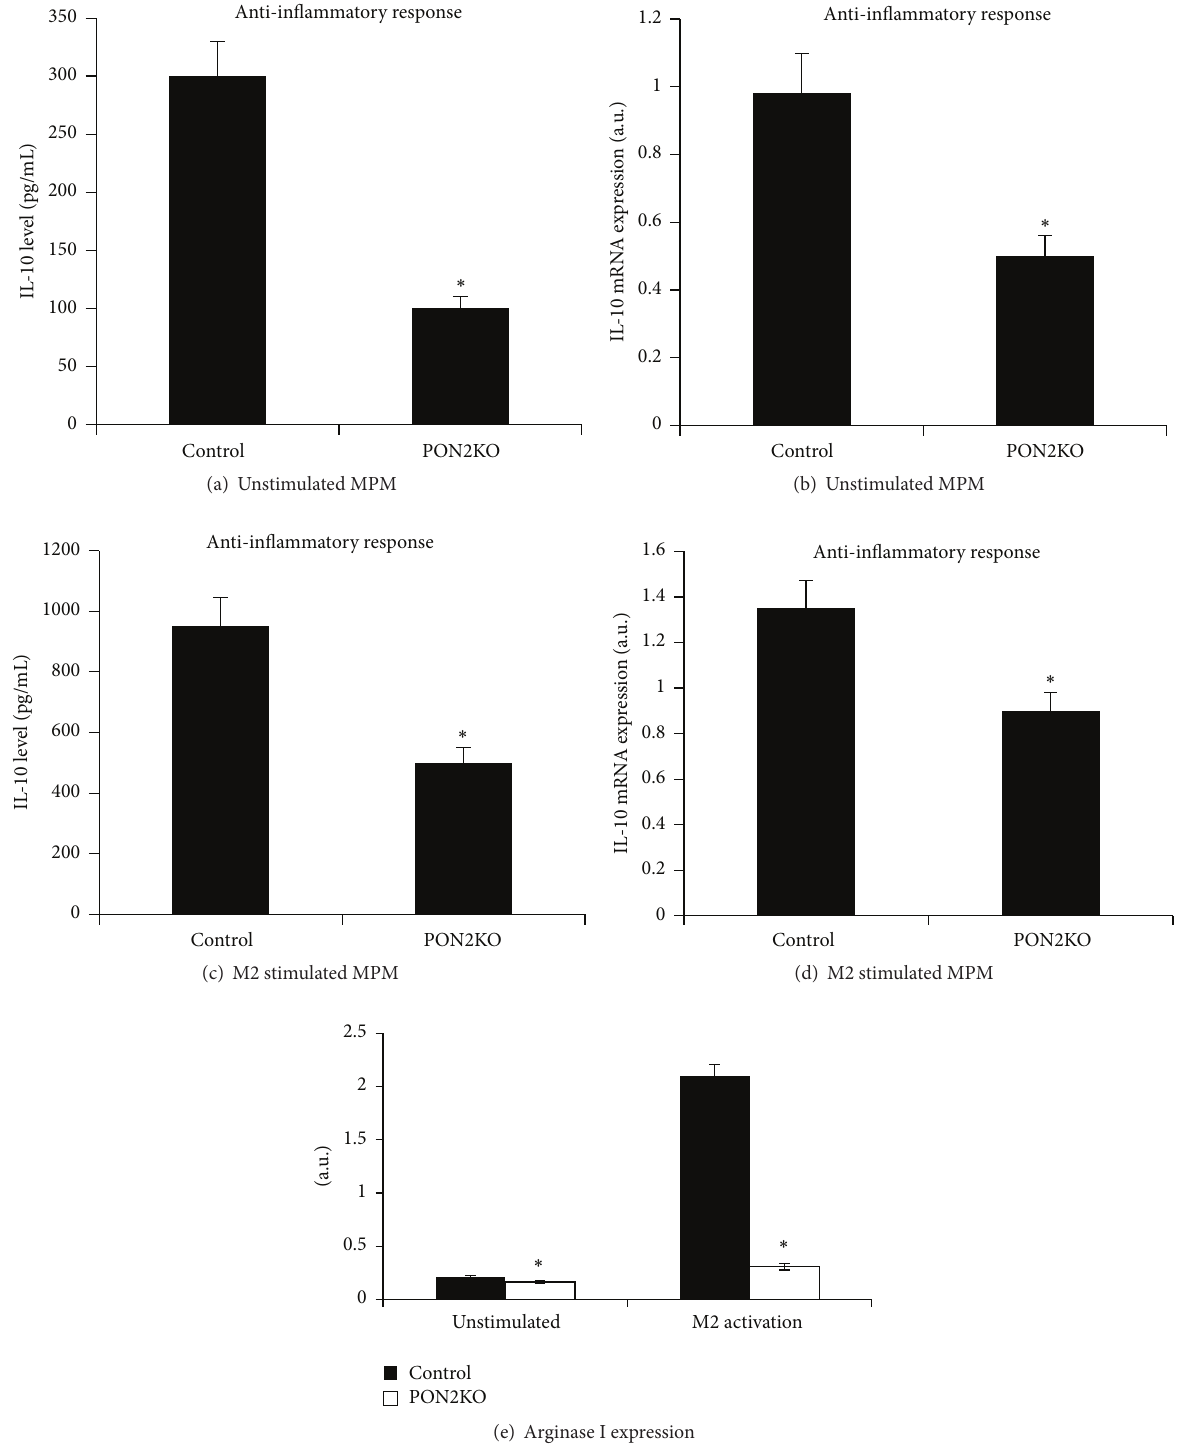
Figure 2: MPM from PON2KO display reduced anti-inflammatory activation. MPM were harvested from 3-month-old control (C57BL/6) male mice and from age matched PON2KO mice. The cells were stimulated toward M2 activation with IL-4 (20ng/mL) for 12 hours. Secretion of IL-10 to the medium was measured under basal (a) or M2 stimulation (c) conditions. IL-10 mRNA expression, analyzed by quantitative PCR and normalized to GAPDH, was measured in the cells under basal (b) or M2 stimulation (d) conditions. Arginase I mRNA expression was also measured under basal or M2 stimulating conditions (e). Results are expressed as mean ± SD ( 𝑛 = 3 ), ∗ 𝑃 < 0.01 , PON2KO MPM versus control